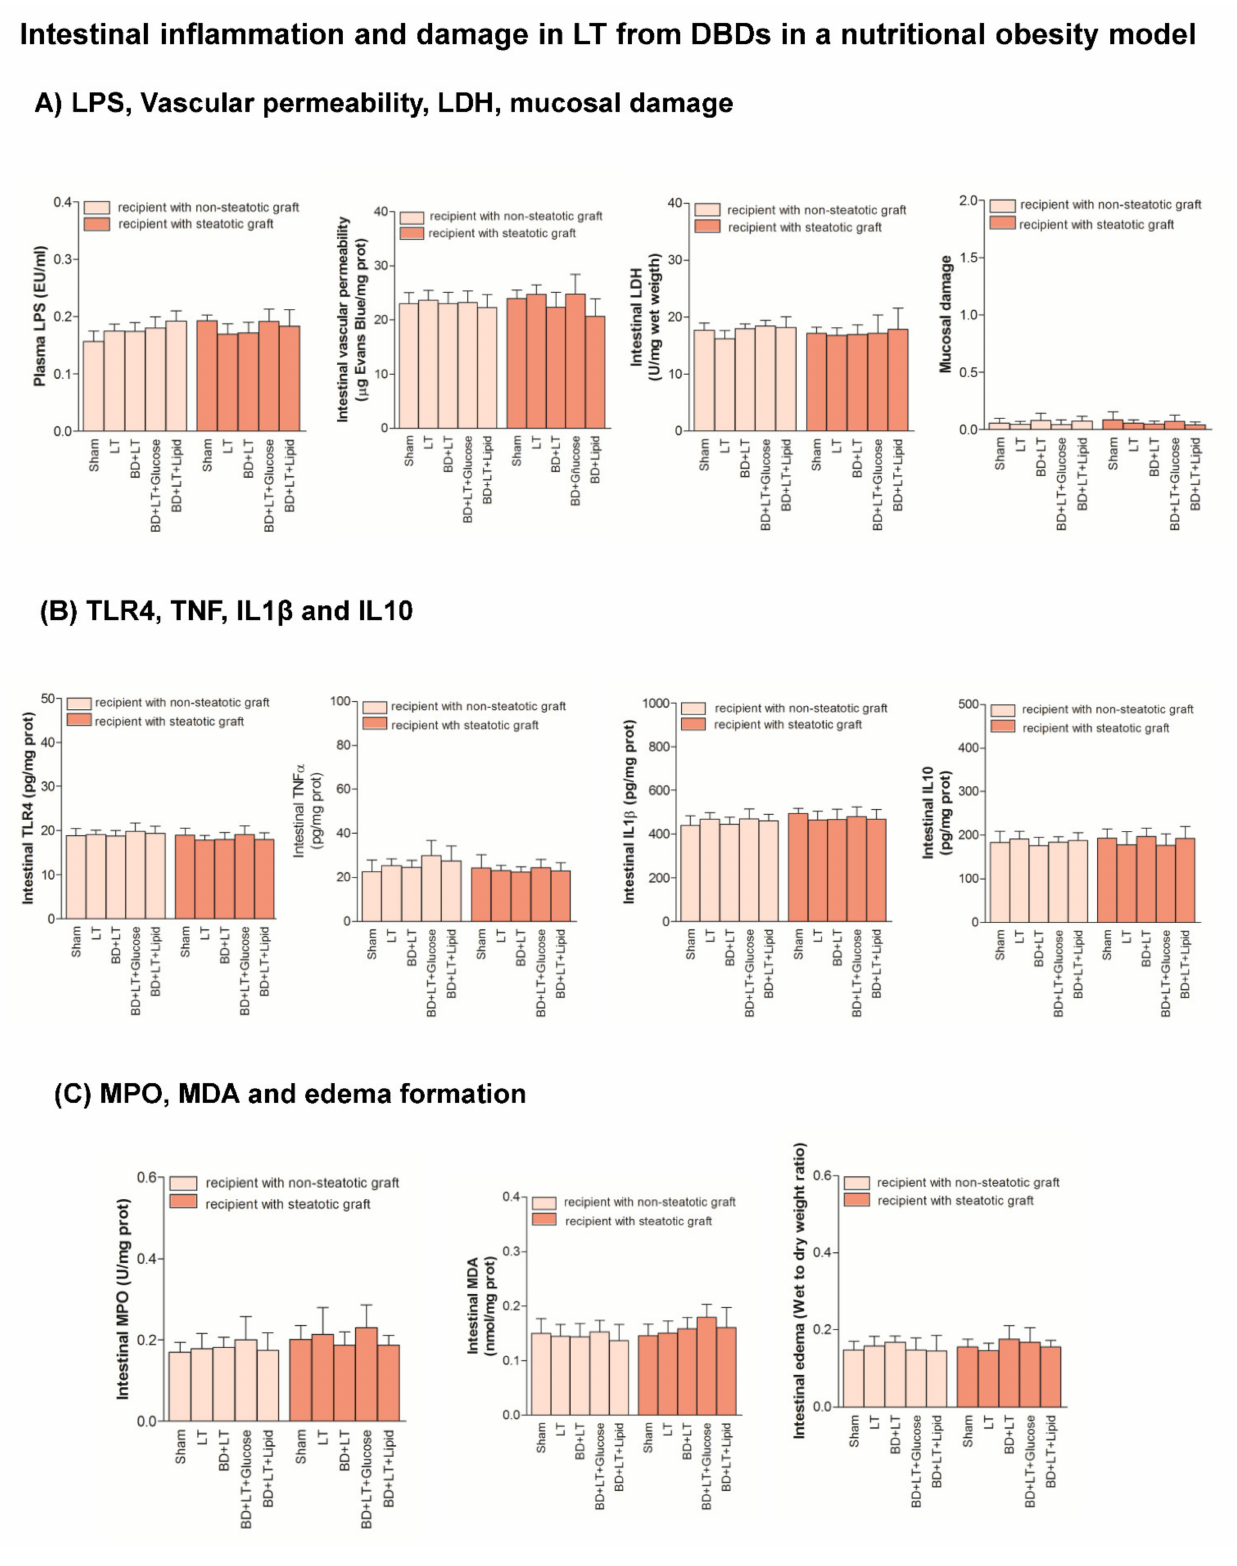
Figure 8. Effects of glucose and lipids on intestinal inflammation and damage in steatotic and non-steatotic LT in a nutritional obesity model. ( A ) LPS in plasma and vascular permeability, Lactate dehydrogenase (LDH) and mucosal damage in intestine. ( B ) Toll like Receptor 4 (TLR4), Tumor necrosis factor (TNF), Interleukin (IL)1 β and Interleukin (IL)10 in intestine. ( C ) Myeloperoxidaase (MPO), Malondialdeyde MDA and edema formation in intestine. Sham vs. LT or BD + LT, p = not significant; LT vs. BD + LT, p = not significant. DBD, Donors after Brain